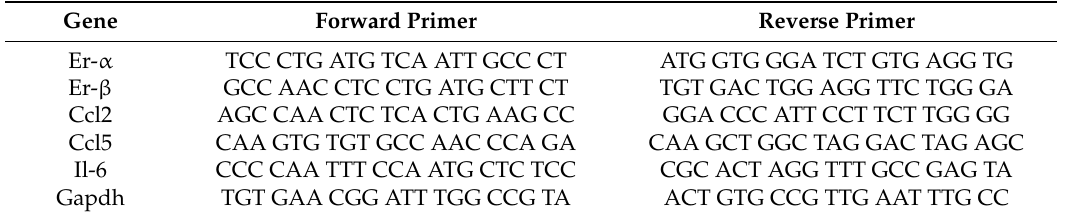
Table 1. Primer sequences for gene amplification by RT-PCR (real-time polymerase chain